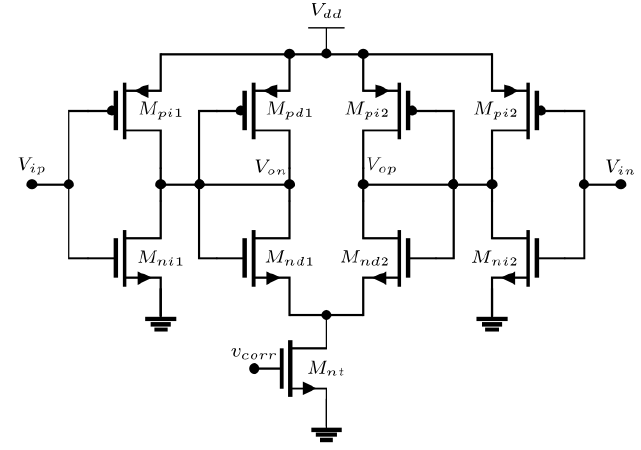
Figure 3. Second-stage gm-gm buffer.